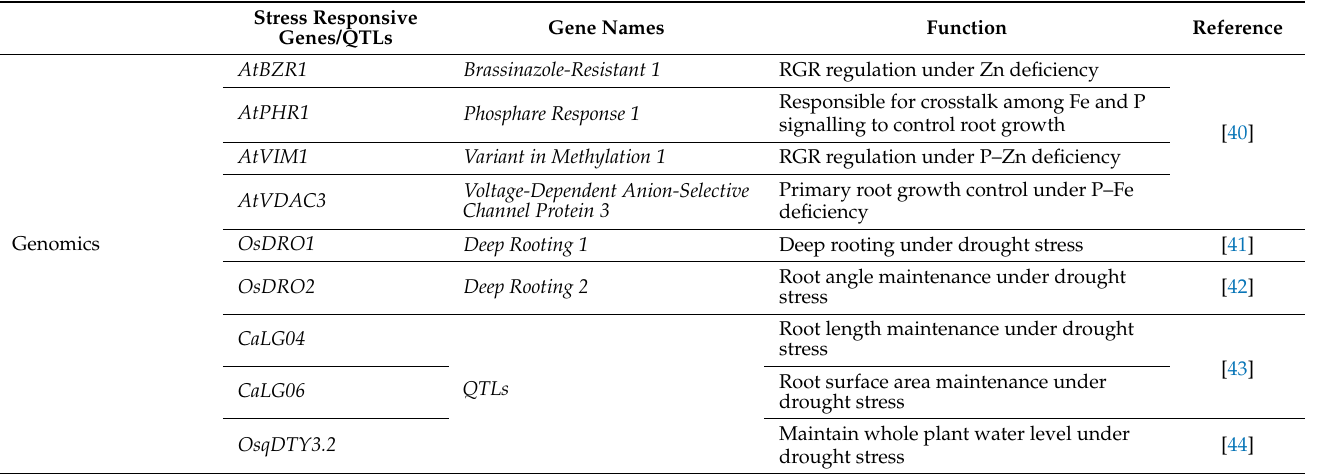
Table 1. Root-responsive genes/gene products confer tolerance against various abiotic stresses. Stress Responsive